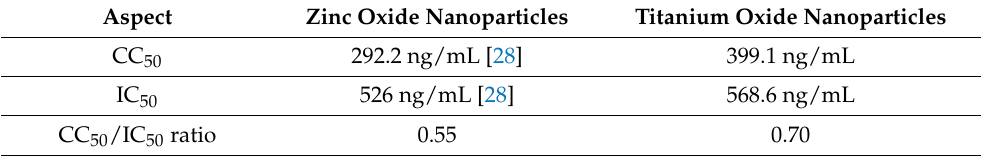
Table 2. Comparison between inhibition activity for SARS-CoV-2 (differences between antiviral activity of both nanoparticles against SARS-CoV-2).